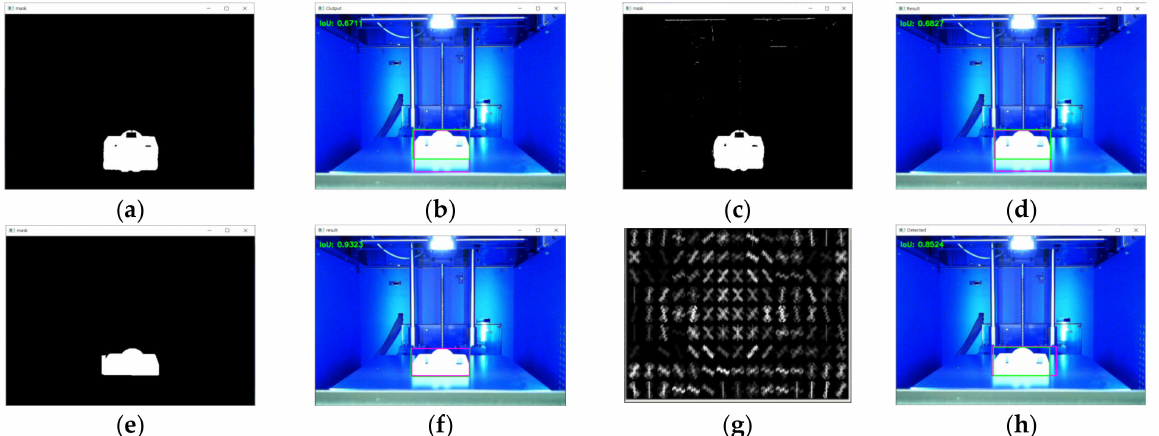
Figure 10. Test 3 product result of background subtraction by the Otsu and GMM algorithms: ( a ) foreground mask of the background subtraction by the Otsu algorithm; ( b ) test result of the background subtraction by the Otsu algorithm; ( c ) foreground mask of the background subtraction by the GMM algorithm; ( d ) test result of the background subtraction by the GMM algorithm; ( e ) foreground mask of the GrabCut algorithm; ( f ) test result of the GrabCut algorithm; ( g ) gradient vector of the HOG algorithm; ( h ) test result of the HOG